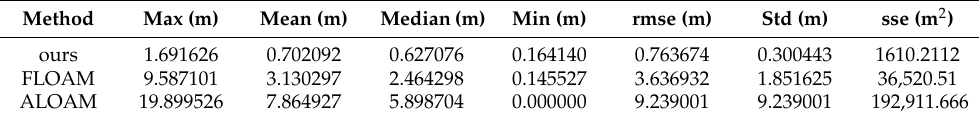
Table 1. The Absolute Pose Error comparison of our method, FLOAM and ALOAM on KITTI05. Method